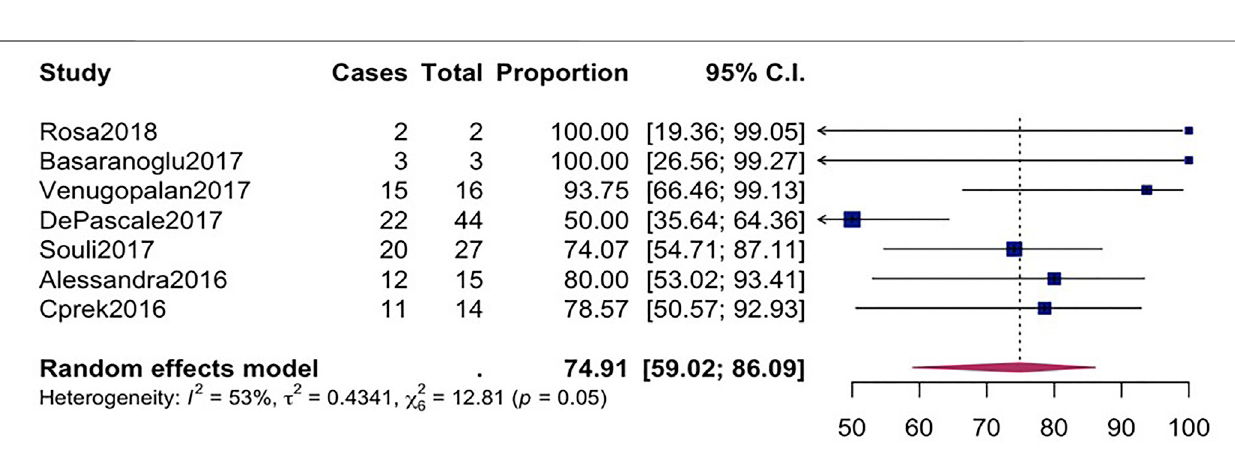
Frontiers in Pharmacology |